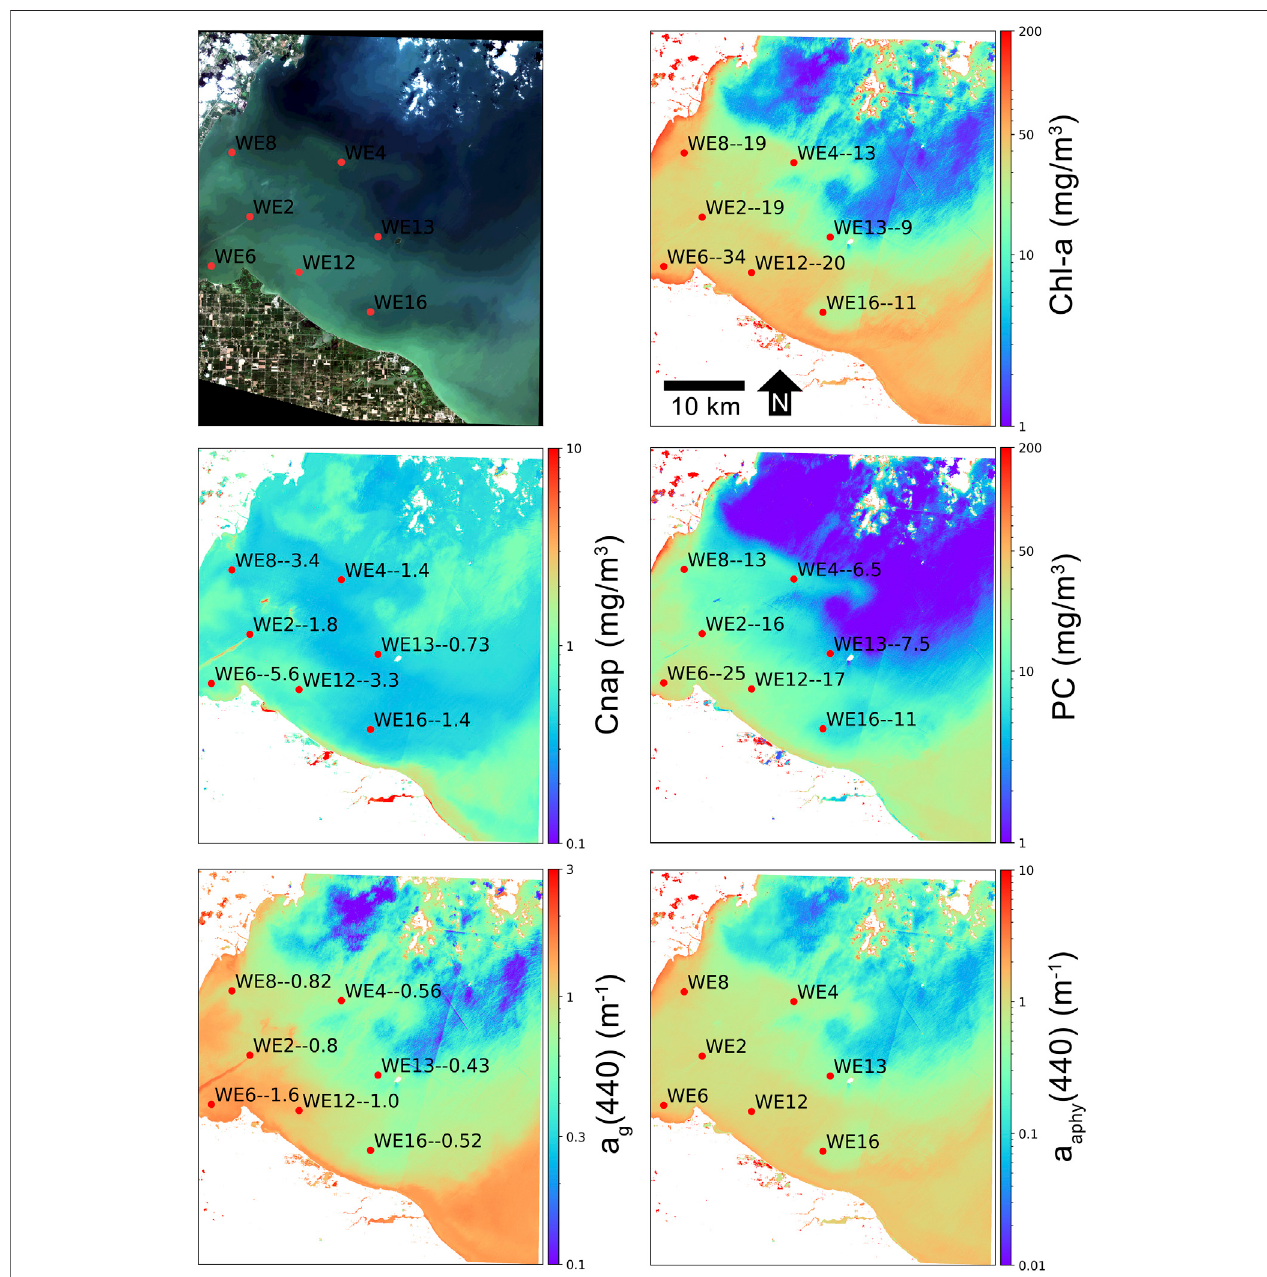
FIGURE 10 | MLP product retrievals over the western basin of Lake Erie on August 13, 2018 using S2 10 m band con fi guration TOA re fl ectance data. In-situ sampling points (red dots) are labeled with the station name followed by the measured quantity of that particular variable, in units shown on the y-axis. In-situ data are from NOAA GERL and